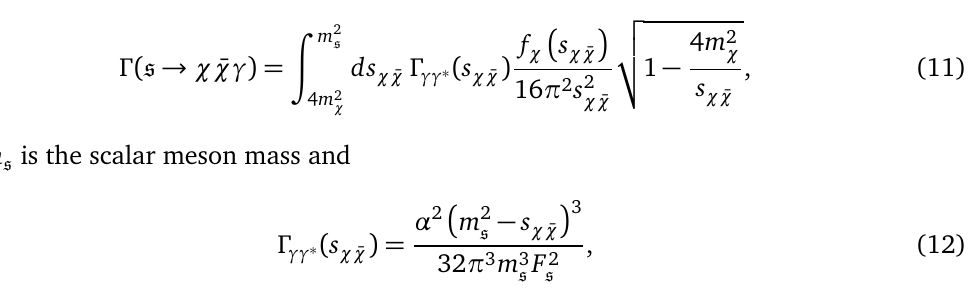
Figure 4: The 90% upper limit exclusion regions for electric d (left) and magnetic µ (right) dipole moments, measured in Bohr magnetons µ LEP II [ 22 ] are also shown. The CHARM II bounds we derive here agree with those found earlier [ 23 ] and are less restrictive than those of